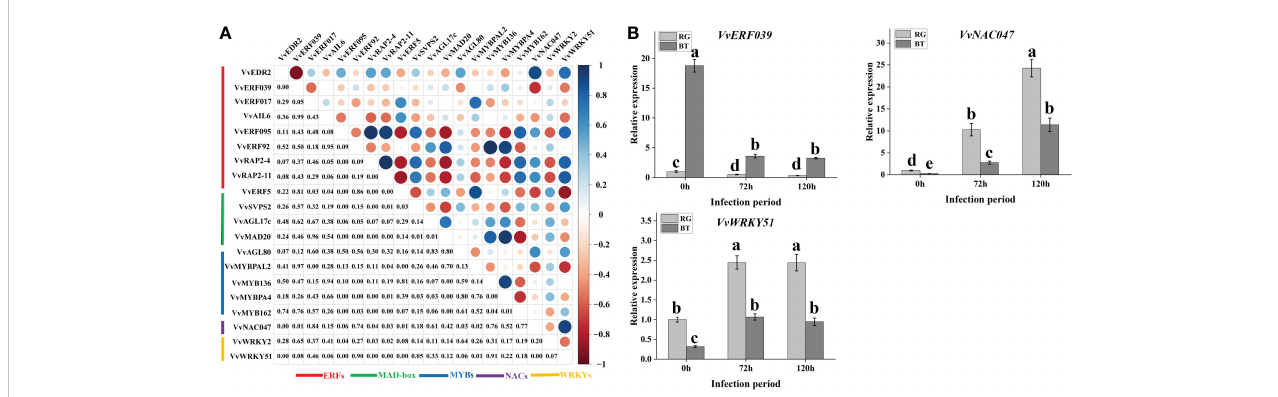
FIGURE 6 Candidate transcription factor fi lter related to VlEDR2 expression and grapevine gray mold resistance. (A) Correlation analysis of transcription factors from different families with candidate gray mold resistance gene VlEDR2 at different infection periods. (B) qRT-PCR analysis of candidate gray mold resistance transcription factors at different infection periods. Light-gray bars represent cultivar ‘ RG, ’ and dark-gray bars represent cultivar ‘ BT. ’ Error bars represent the standard deviation of three biological replicates. Lowercase letters on the bar chart represent signi fi cant differences between the two cultivars and different developmental stages according to Duncan ’ s multiple range test at P <